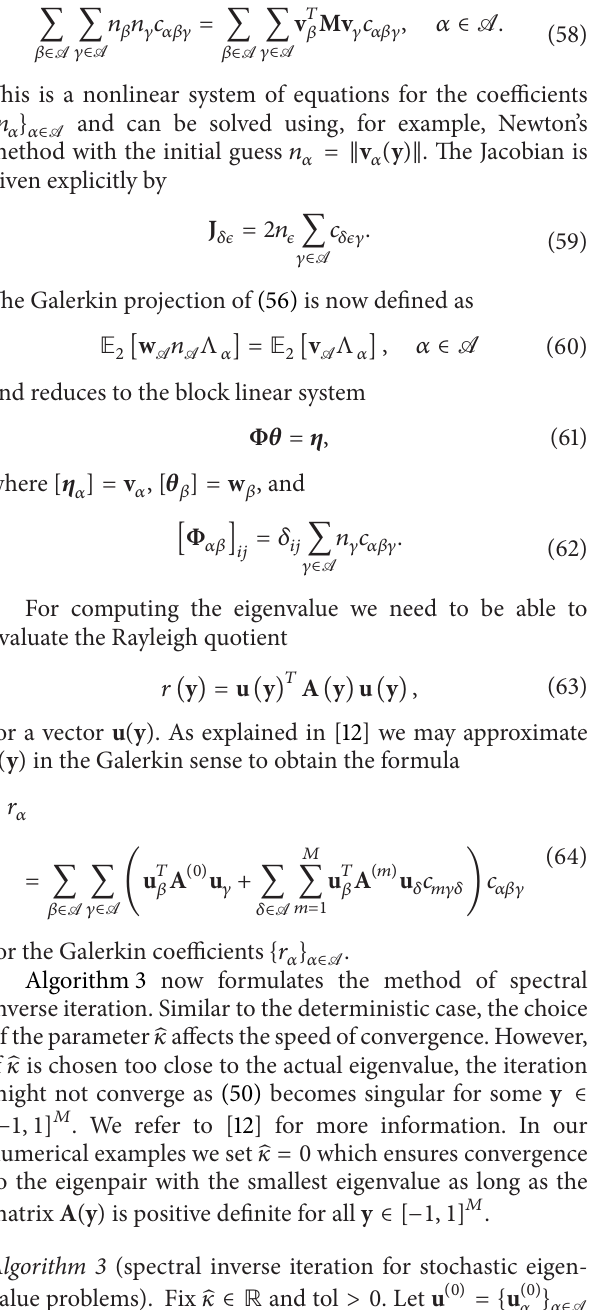
Algorithm 3 (spectral inverse iteration for stochastic